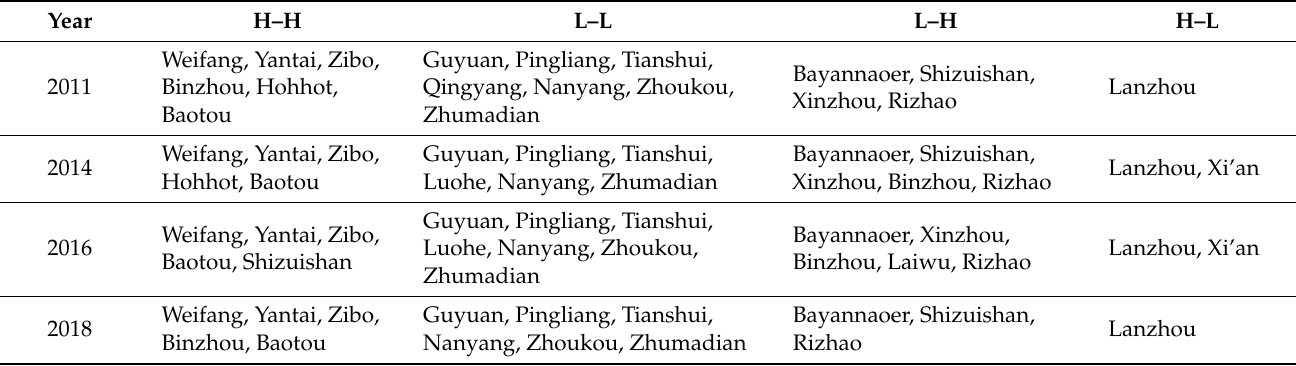
Table 3. Local spatial evolution of URI in the